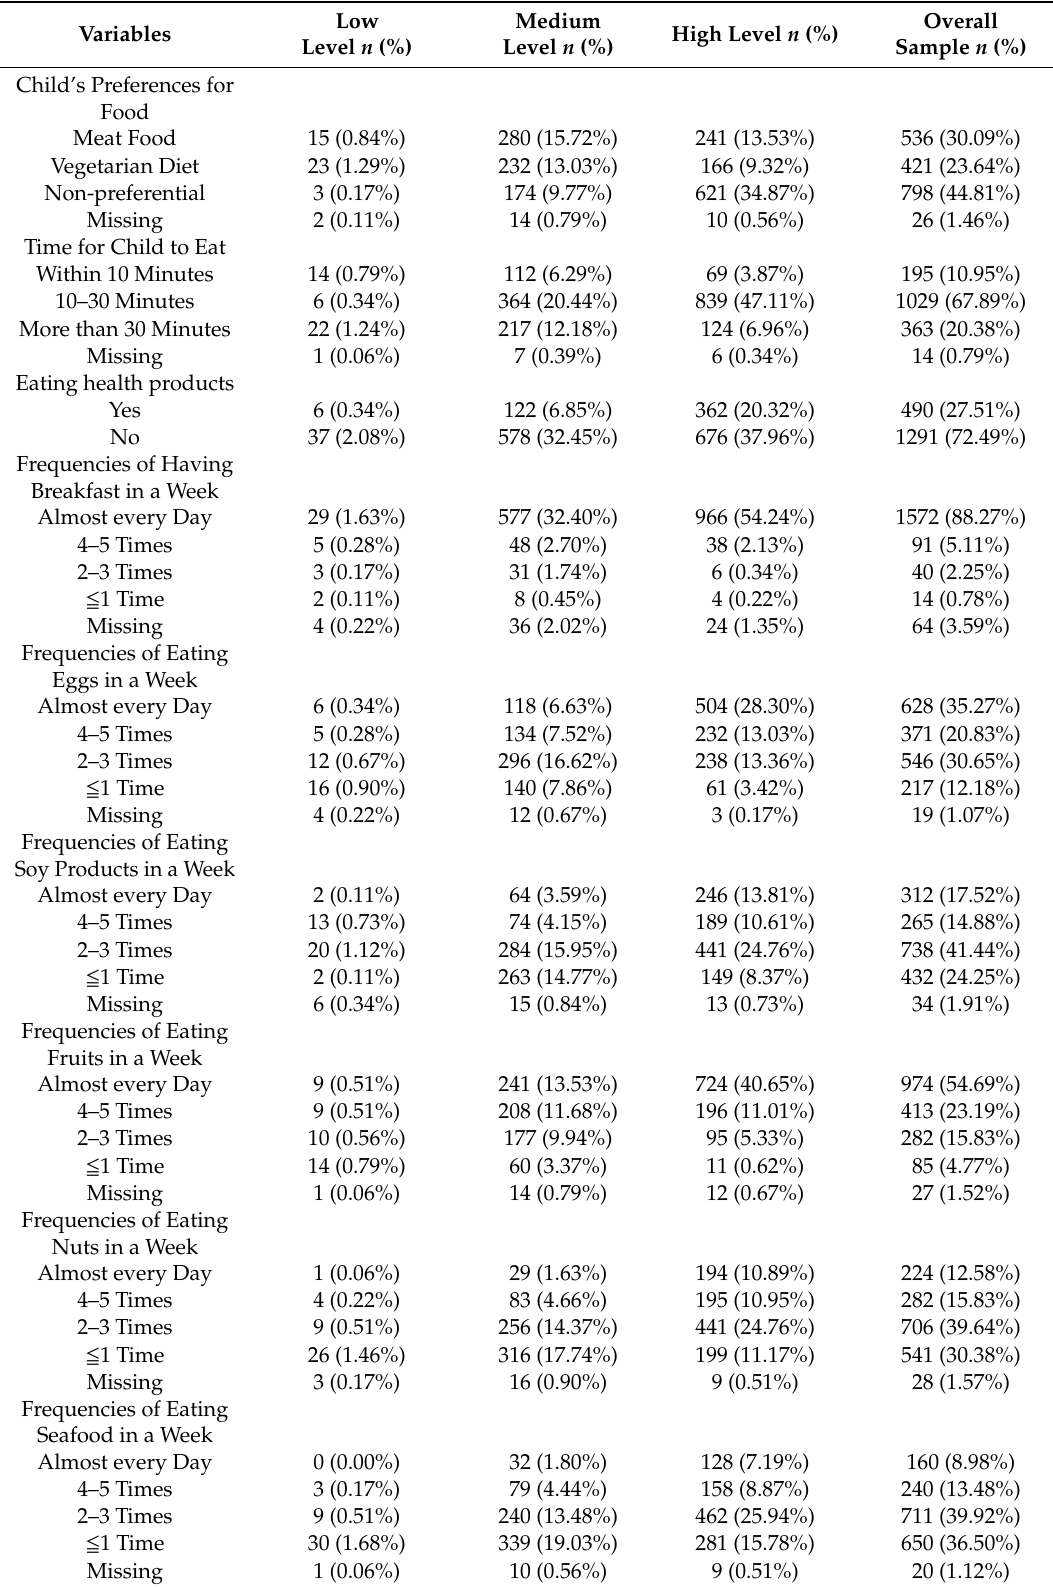
Table 3. Children’s eating